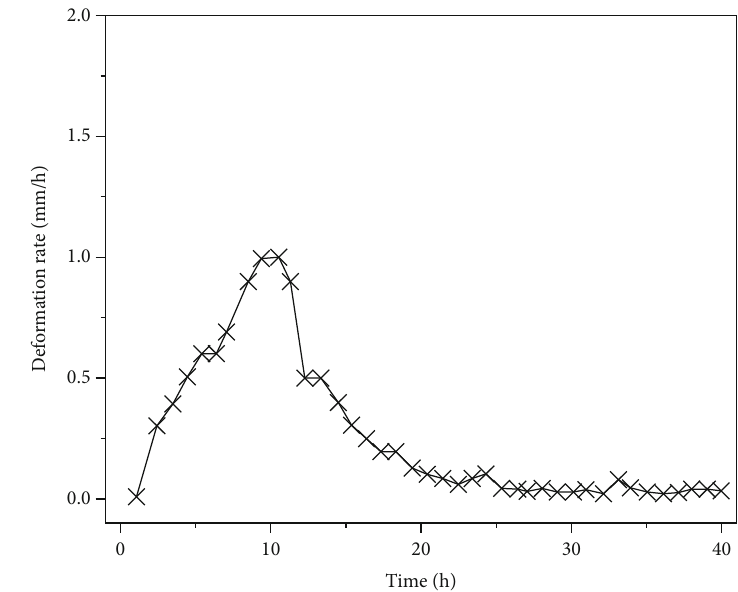
Figure 11: Deformation rate vs. time for SS.